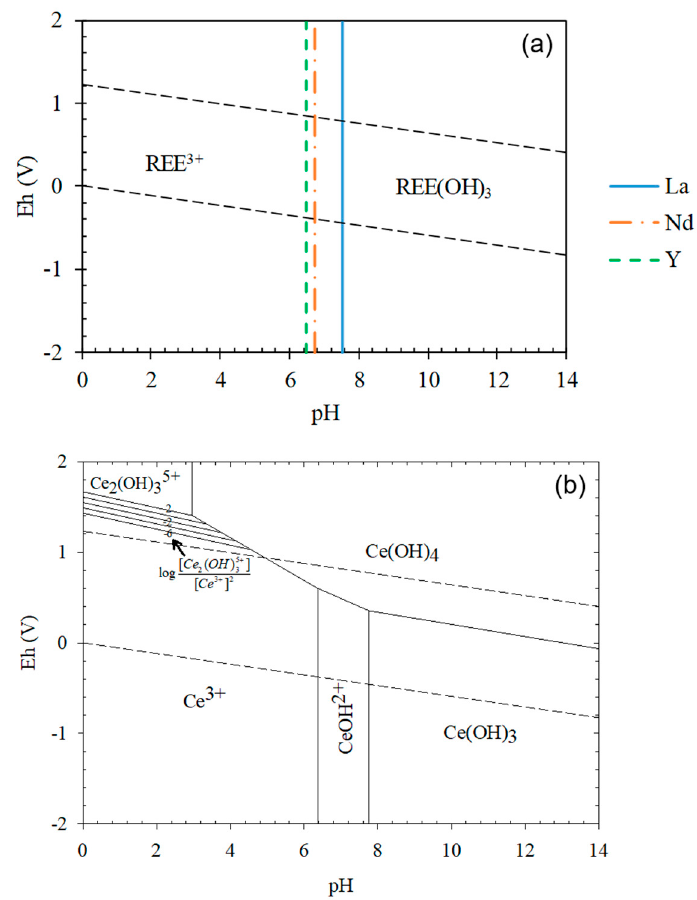
Figure 5. Eh–pH diagrams of REE systems: ( a ) (La, Nd and Y)–OH; ( b ) Ce–OH ([Ce], [La], [Nd], [Y] = 0.01 M).